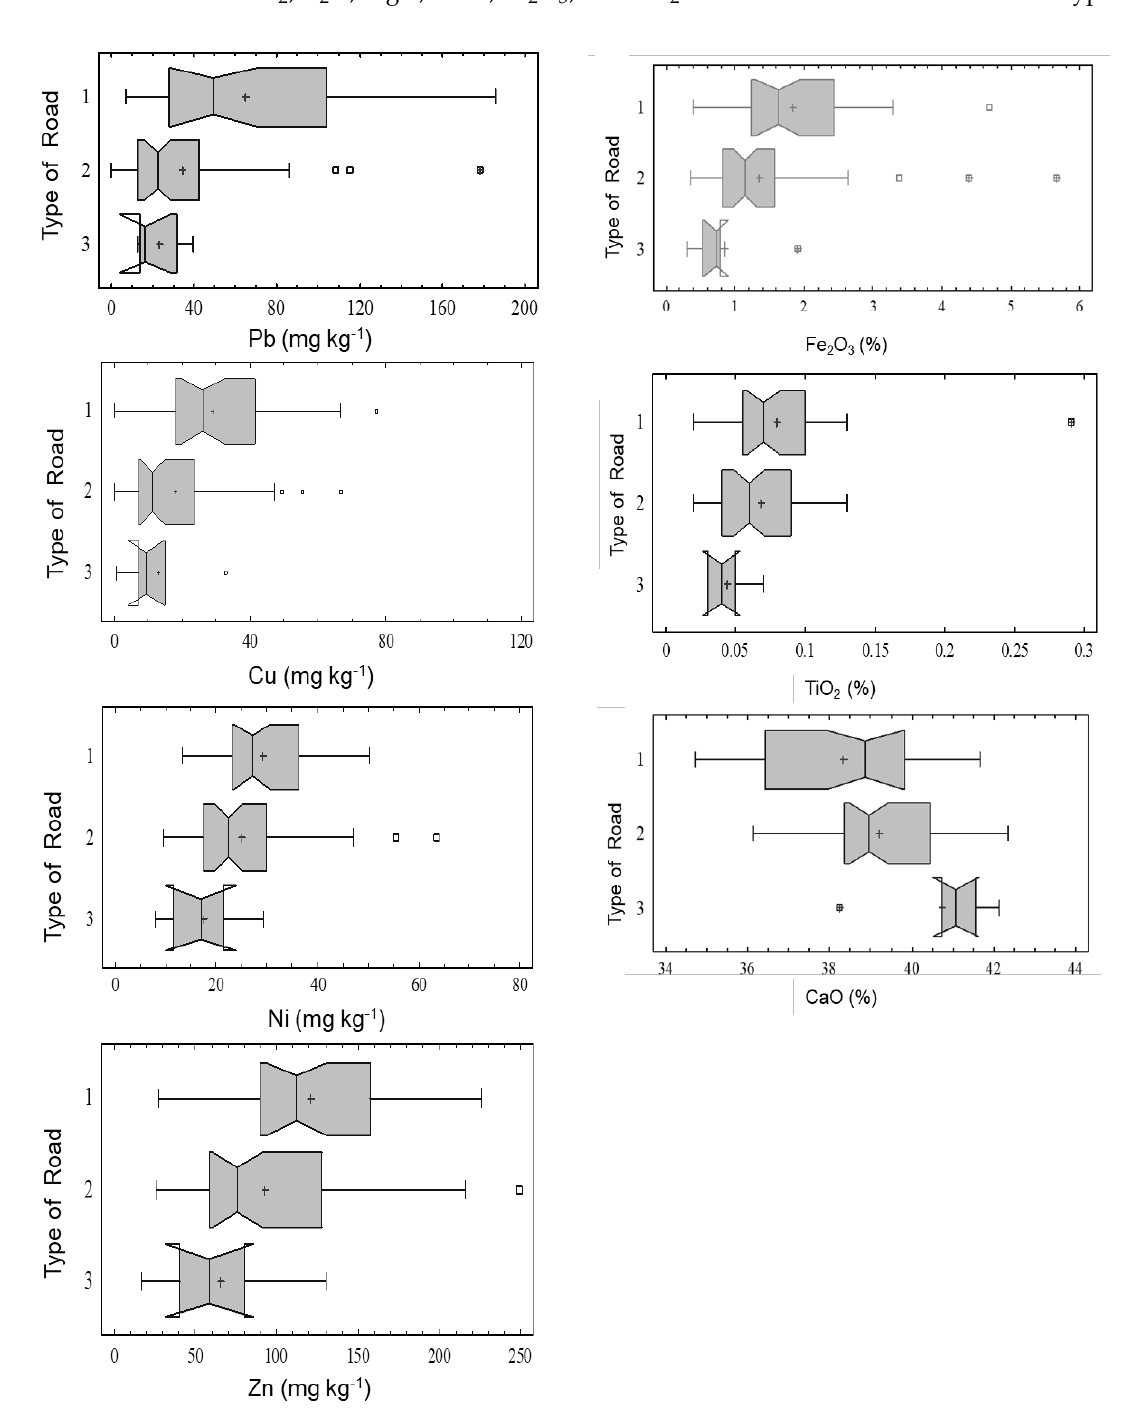
Figure 5. Comparison of medians of presumably contaminating elements and oxides by road dust. Primary road, 1; secondary roads, 2; tertiary roads, 3.